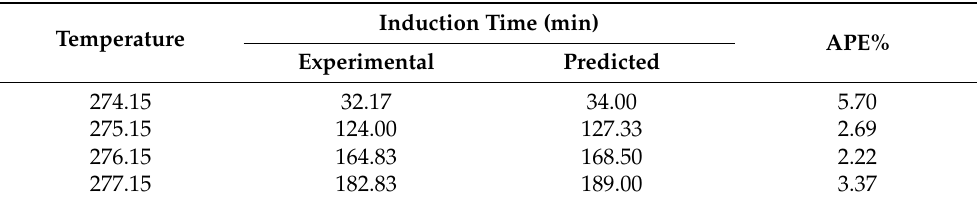
Table 4. Experimental and predicted induction times of CH 4 hydrate formation in the presence of